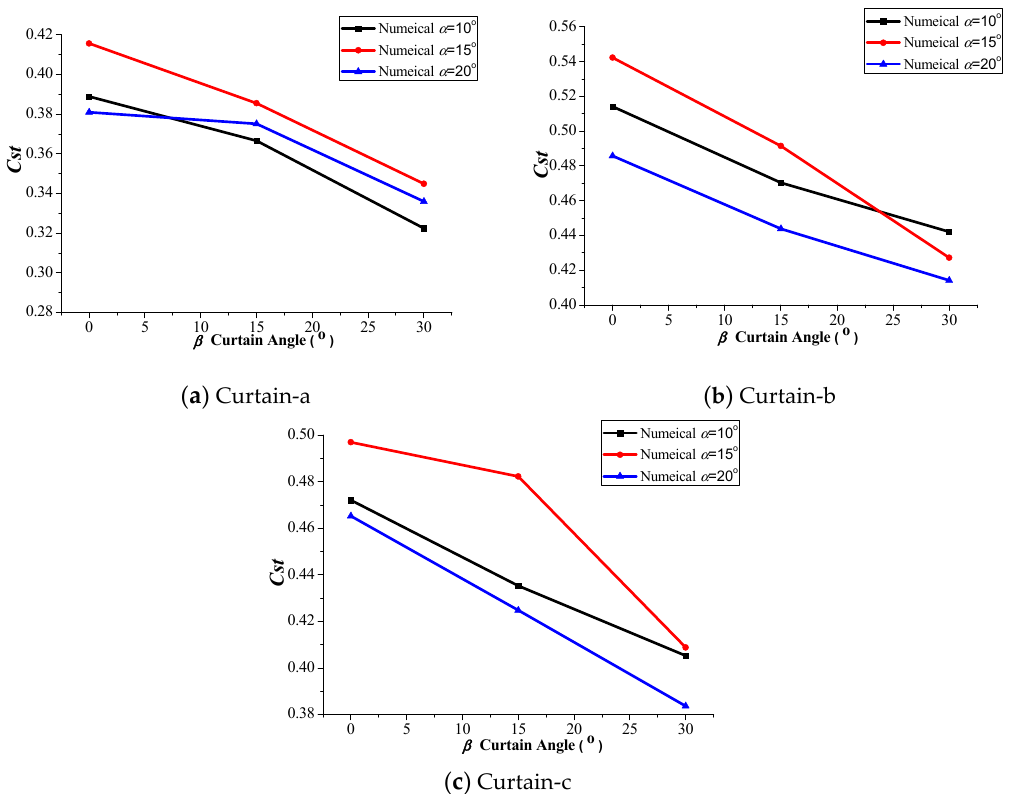
Figure 12. Static torque coefficients of ( a ) Curtain-a, ( b ) Curtain-b and ( c ) Curtain-c ( θ = 60°).